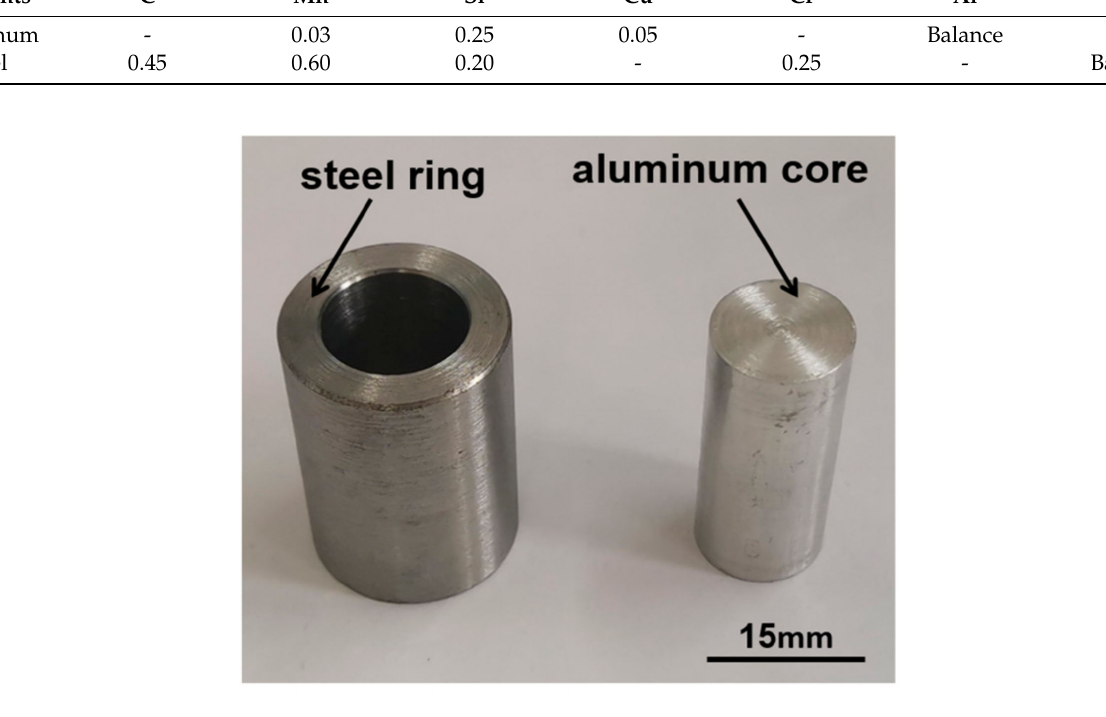
Figure 1. Steel ring and aluminum